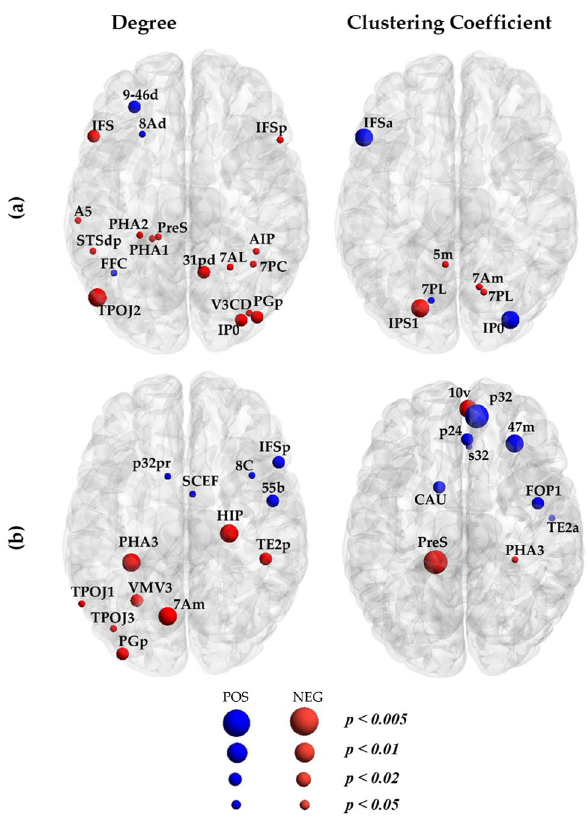
Figure 4. Regions showing significant association with times used cannabis in ( a ) structural and ( b ) functional networks. Nodes in red and blue show a negative (NEG) and positive (POS) association with times used cannabis, respectively. The node size represents the significant level ( p < 0.05, p < 0.02, p < 0.01 and p < 0.005, uncorrected ) with larger nodes showing smaller p values. After FDR correction, only the PreS region was found to be statistically